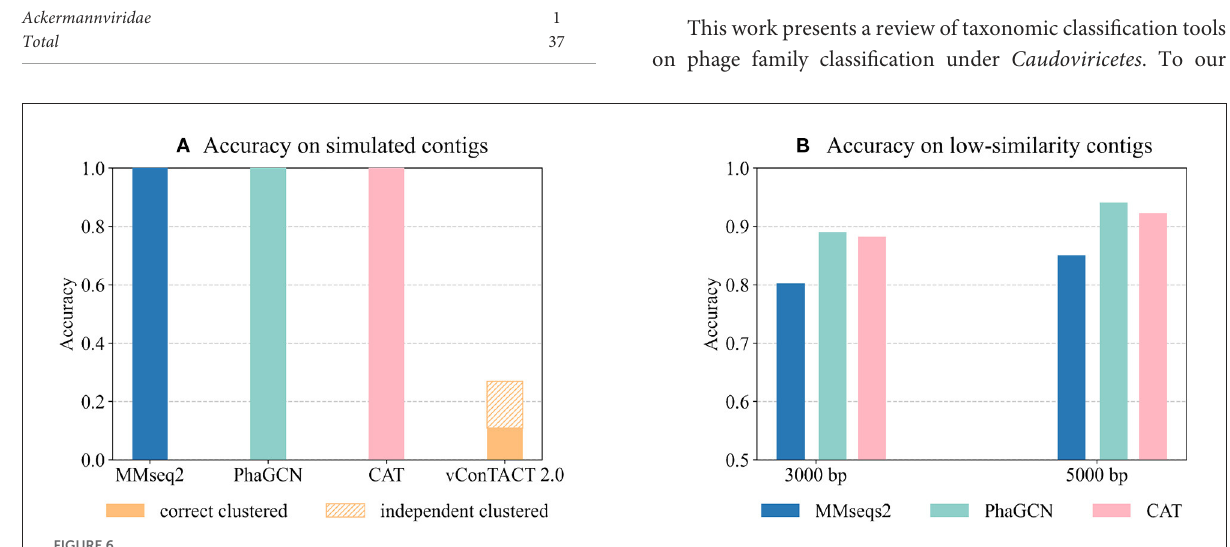
FIGURE6 (A) The performance of the four tools on the simulated metagenomic dataset. The bars show the accuracy on all inputs. The top part with patterns in vConTACT 2.0 shows the percentage of contigs that are not clustered with any reference genome. (B) The performance of each tool on the two low-similarity datasets. Each bar shows the tools’ accuracy on all input